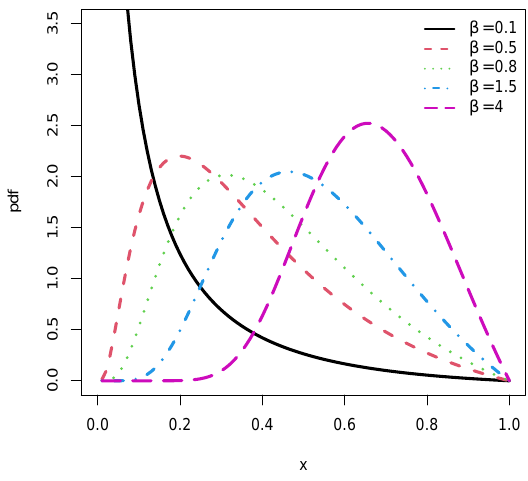
Figure 2. Several curves of the pdf of the unit-Rayleigh